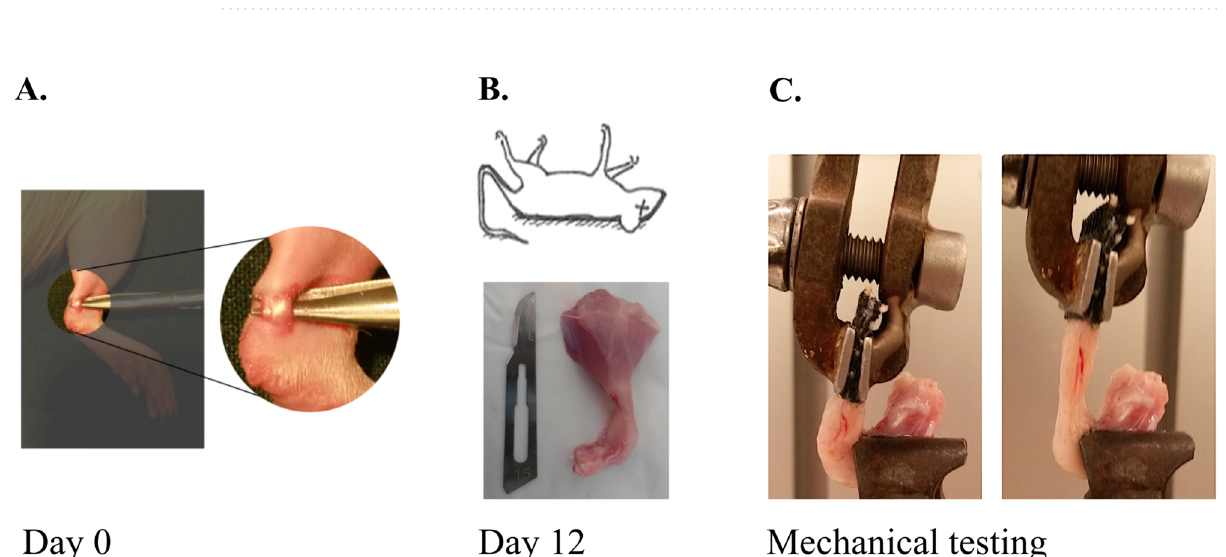
Table 2. Study design for mechanical measurements. Precond. preconditioning; × means that the procedure was executed.